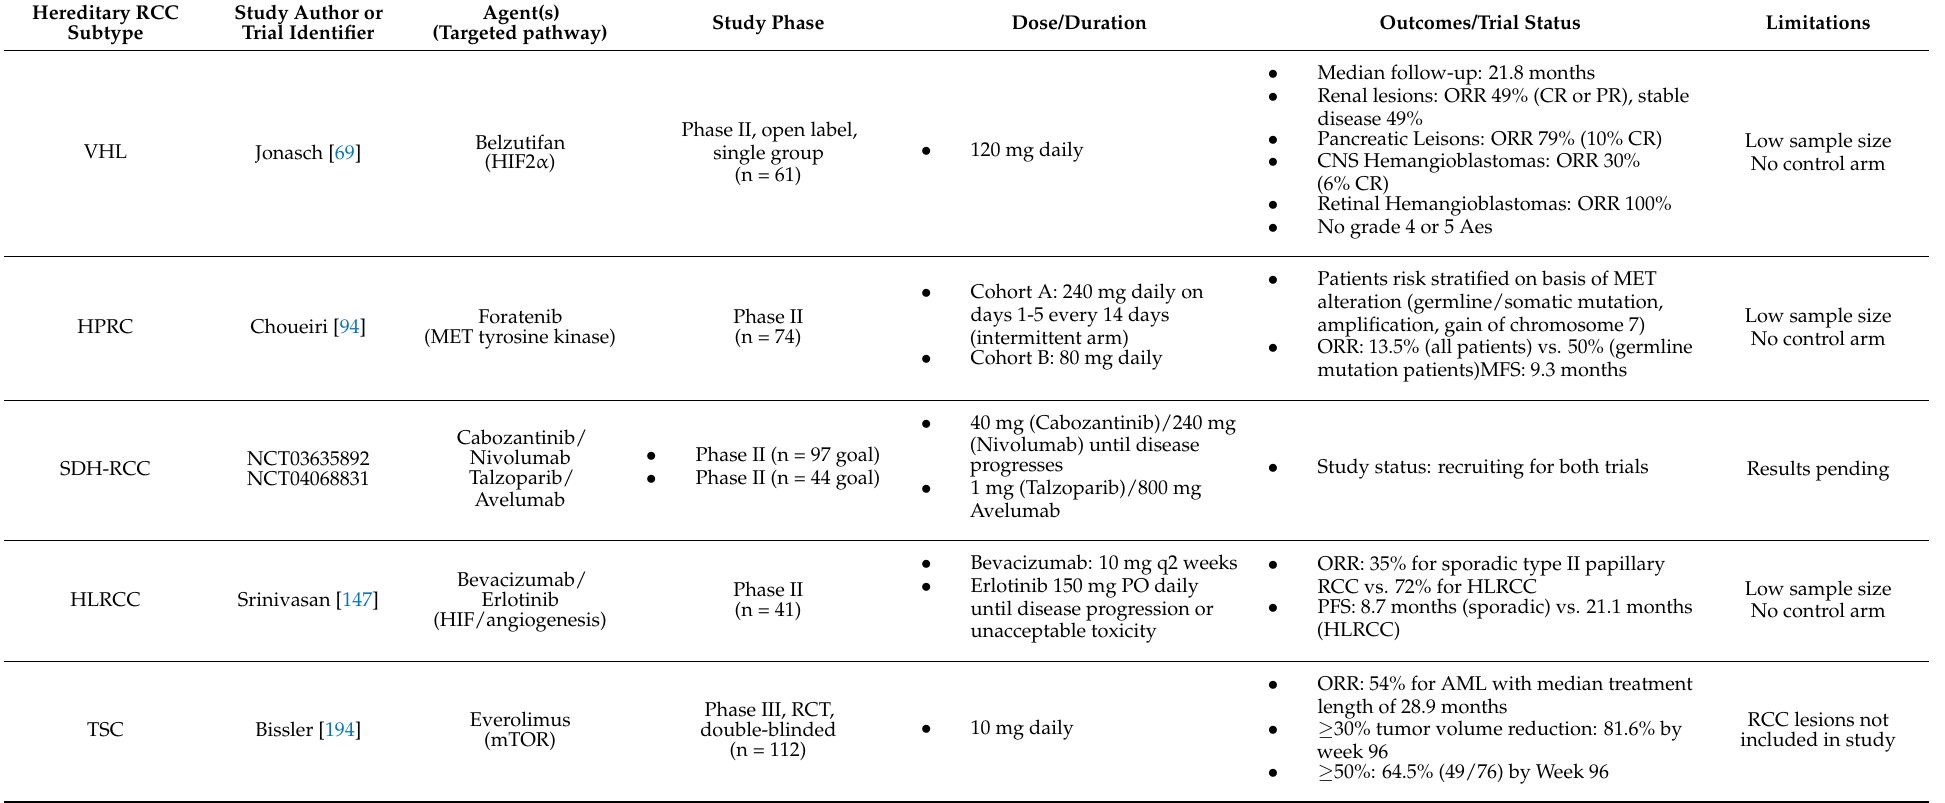
Table 2. Highlighted clinical studies utilizing RCC subtype-specific therapies and their